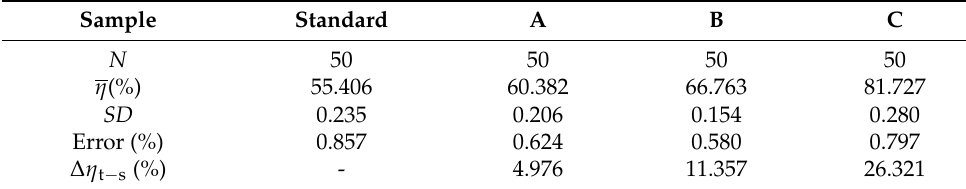
Table 1. Statistical analysis results of the measurement data of 5